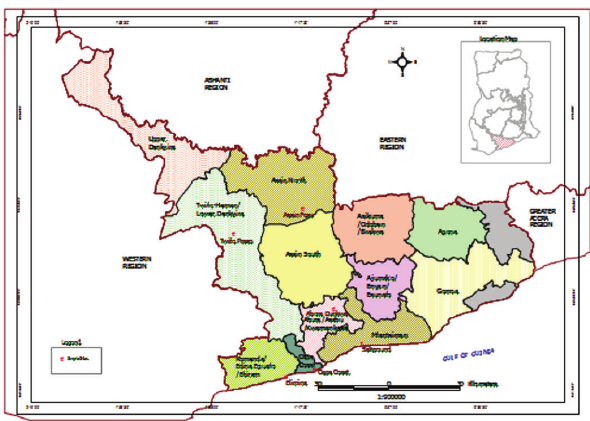
Figure 1: Map of Central Region of Ghana showing